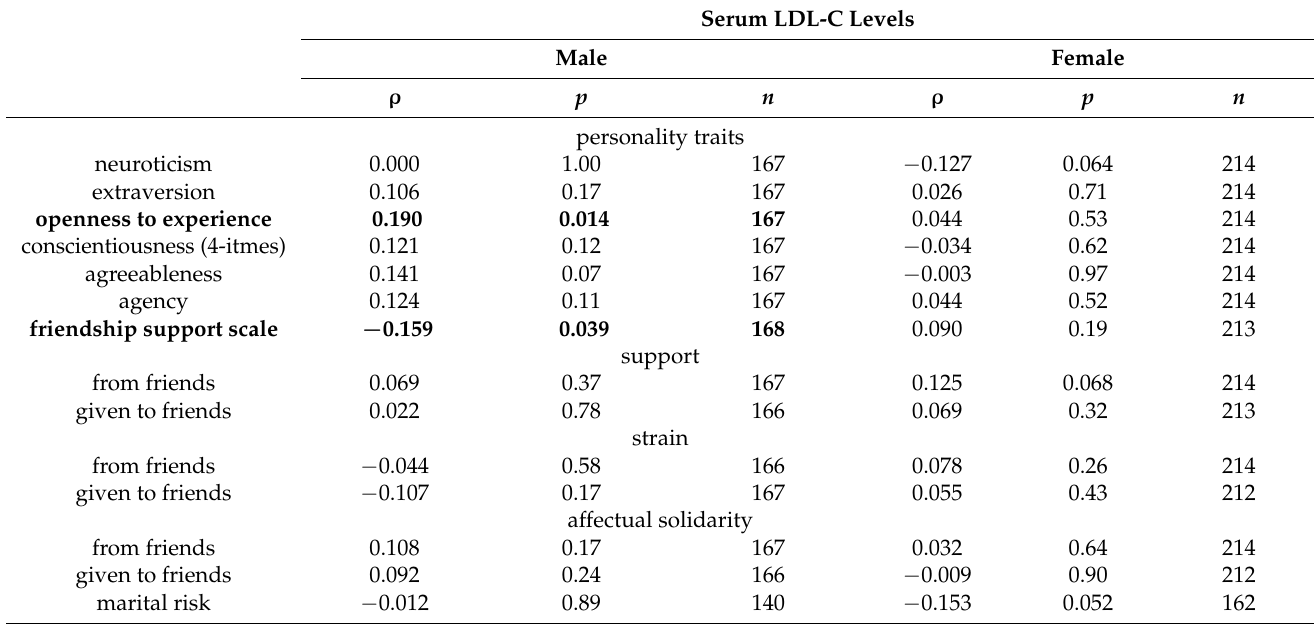
Table 1. The relationships between serum LDL-C levels, six personality traits, and “problems of close interpersonal